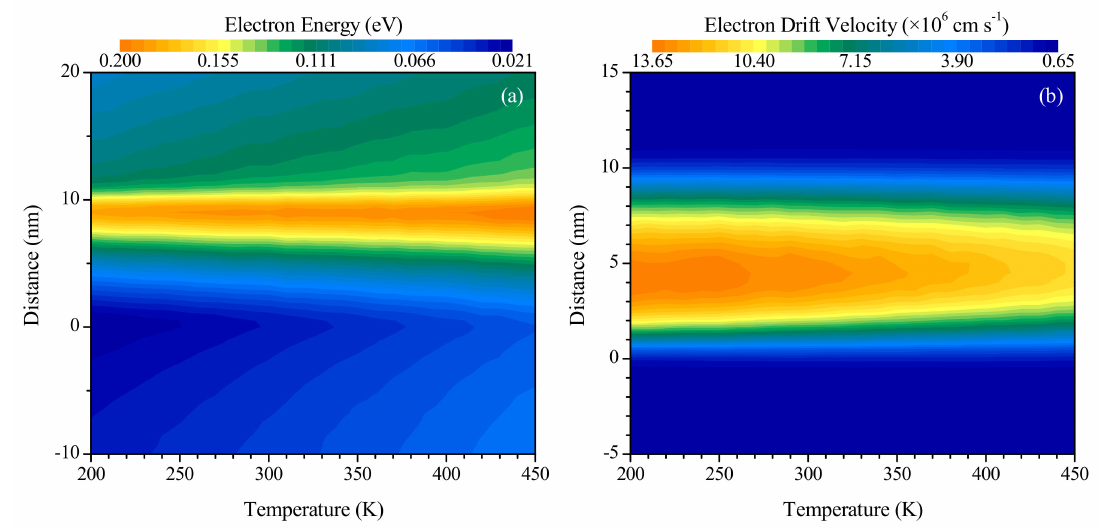
Figure 8. Variation of the distributions of ( a ) electron energy and ( b ) electron drift velocity over a section of the total device length with initial temperature.